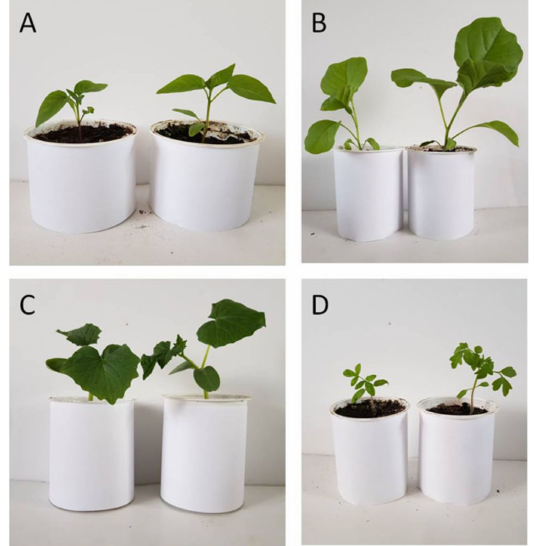
Figure 3. E ff ect of photoconversion polymer film on the size of plant leaves. Photographs of plants cultivated under a common (on the left of the image) and photoconversion (on the right of the image) film. ( A ) Capsicum annuum L.; ( B ) Solanum melongena ; ( C ) Cucumis sativus ; ( D ) Solanum lycopersicum